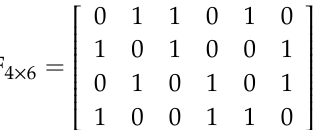
4 complex matrix.